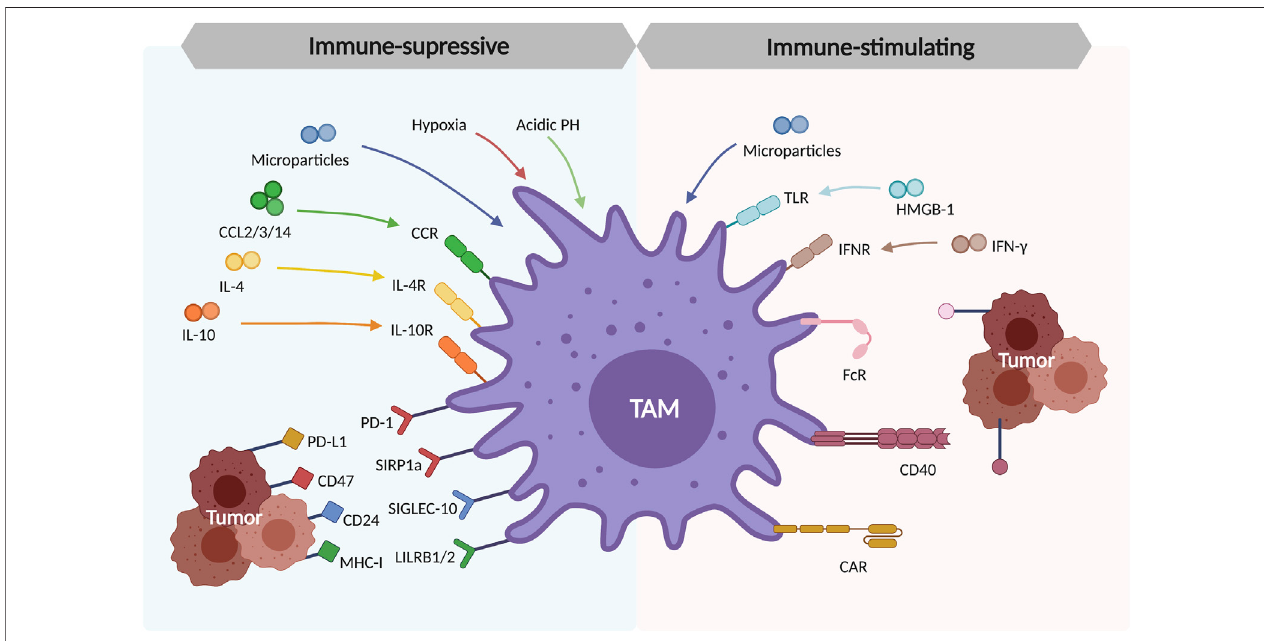
FIGURE 3 | Polarization and formation of tumor-associated macrophages (TAMs) in TME. The tissue-resident macrophages and recruited macrophages from monocytes are the origins of TAMs. These TAMs are polarized in response to the cytokines produced by tumor cells in TME (CCL2/3/14, IL-4, and IL-10), the environmental factors like hypoxia and acidic PH in TME, the immunosuppressive checkpoints (PD-1/PD-L1, CD47/SIRP1a, CD24/SIGLEC-10, MHC-I/LILRB1/2).